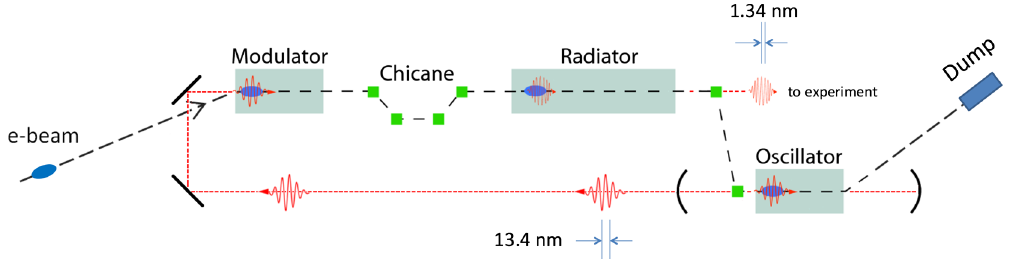
FIG. 1. A diagram of the HGHG ‘‘radiator-first’’